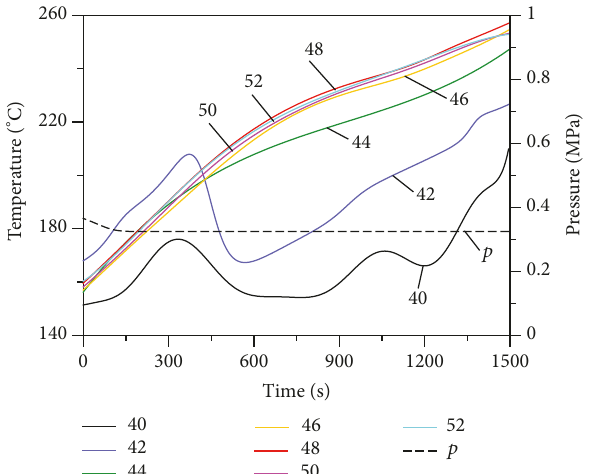
Figure 4: Measured steam pressure and temperature transients on thereheaterouterheadersurface;nodes44–52areshowninFigure1.